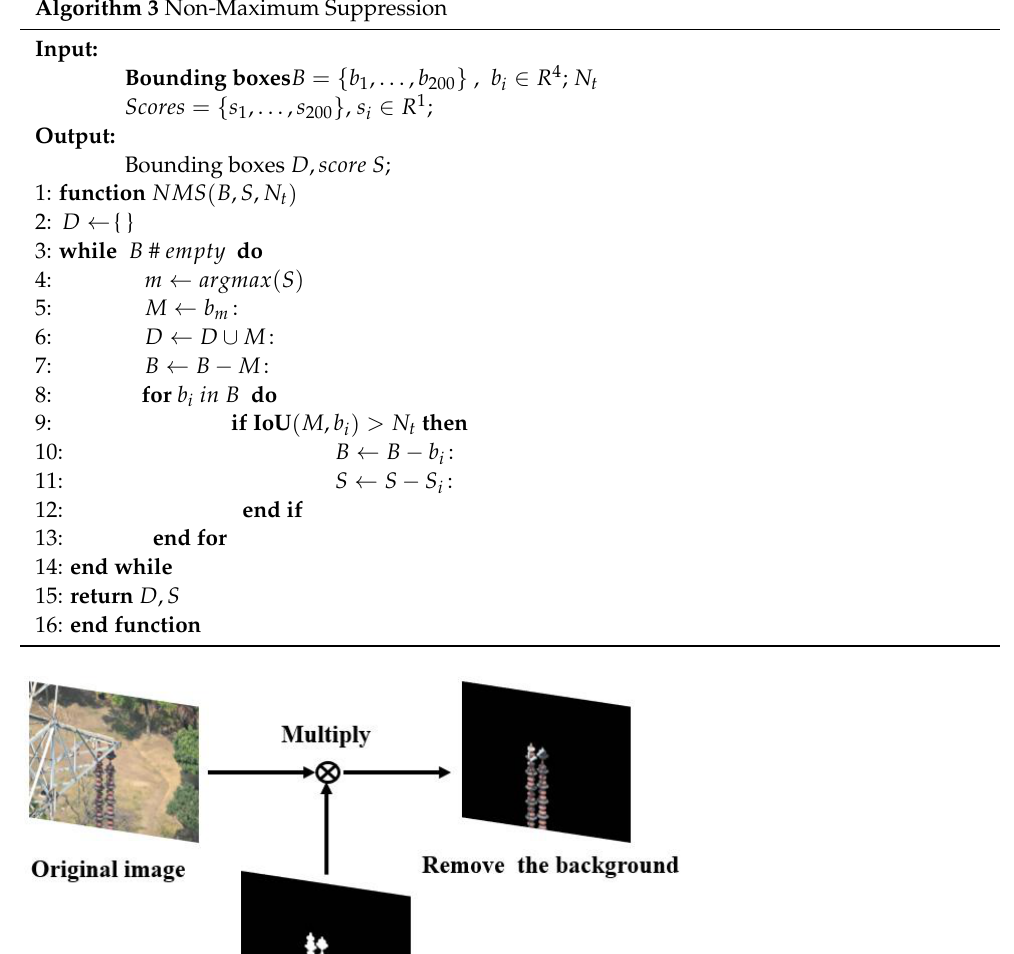
Algorithm 3 Non-Maximum Suppression